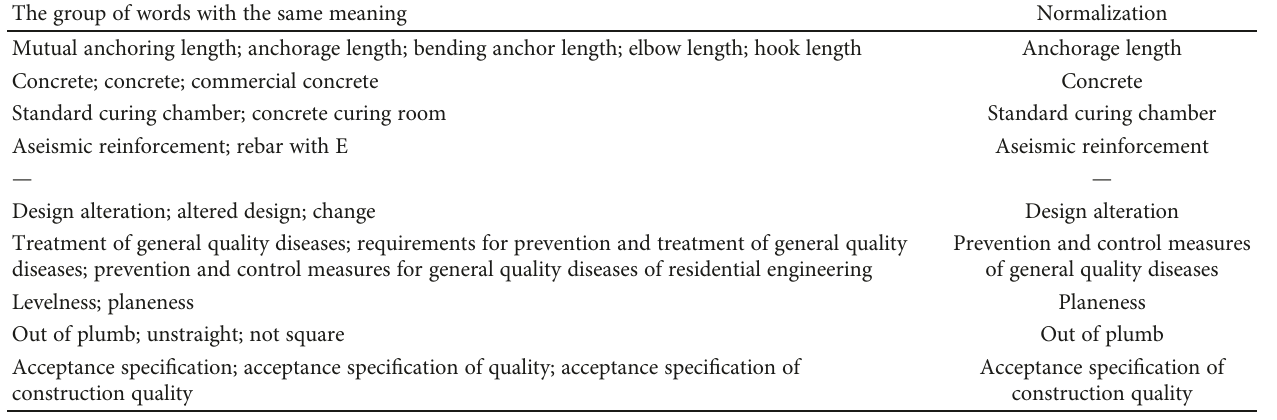
Table 1: Mapping of synonyms for architectural